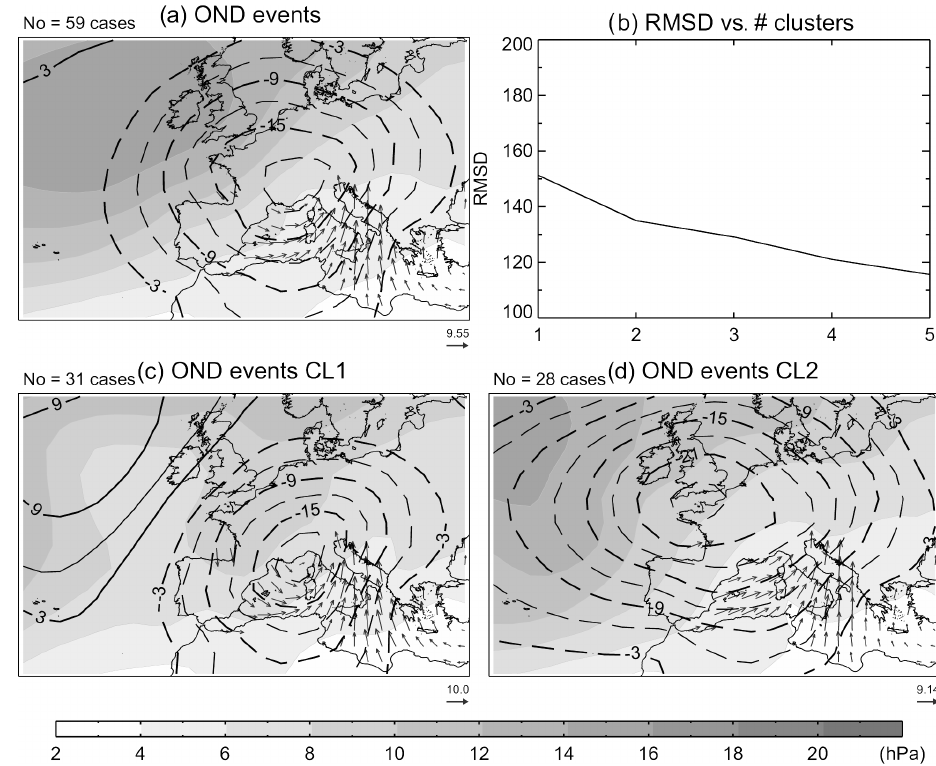
Figure 7. (a) Composite of daily anomalies of sea level pressure (MSLP) over [30, 60] ◦ N, [30 ◦ W, 30 ◦ E] (contours, hPa) and 10m wind vector over the Mediterranean Sea (arrows, ms − 1 ) for autumn (October–November–December, OND) daily mean detrended water heights above the 99.5th percentile of the 1948–2018 distribution. Shading shows the standard deviation of the composited MSLP fields. The number of cases is shown in the top left corner. The modulus of a reference wind speed vector is shown in the bottom right corner. (b) Root mean square difference (RMSD) of the daily standardized anomalies of MSLP and 10m wind vector as a function of the number of clusters. RMSDs are computed with respect to the centroid of the respective cluster. (c, d) As (a) but when surge events are split in two groups, which are referred to as cluster one (CL1) and two (CL2) and correspond to the choice of two clusters in (b) . Note that (a) is equivalent to one cluster with all events. Data sources: NCEP/NCAR reanalysis (Kalnay et al.,